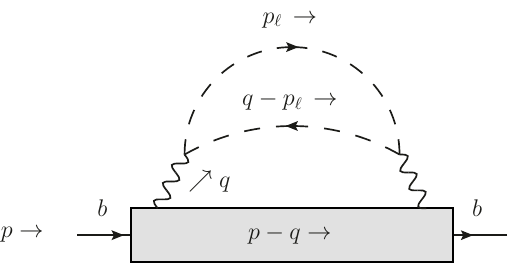
Figure 2 . Our convention for the loop momentum routing. Charged lepton and neutrino momenta are p and q − p , respectively. The external bottom quark momentum is p . Additional loops of ‘ ‘ gluons and quarks are denoted generically with the gray blob. The arrows on the fermion lines indicate the fermion direction whereas the arrows next to the lines denote the momentum